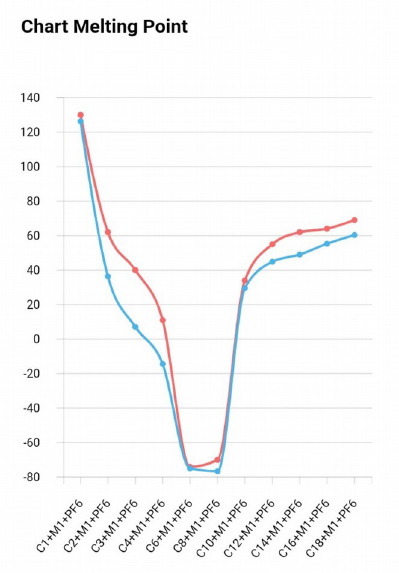
Figure 3. Graph of the effect of the alkyl chain on the melting